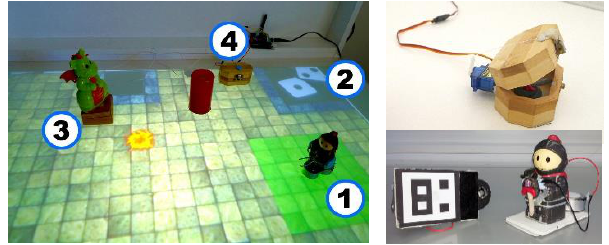
Figure 7. Dragon’s Cave game. Left: Different playing pieces. Right: Chest, Hero and Sword